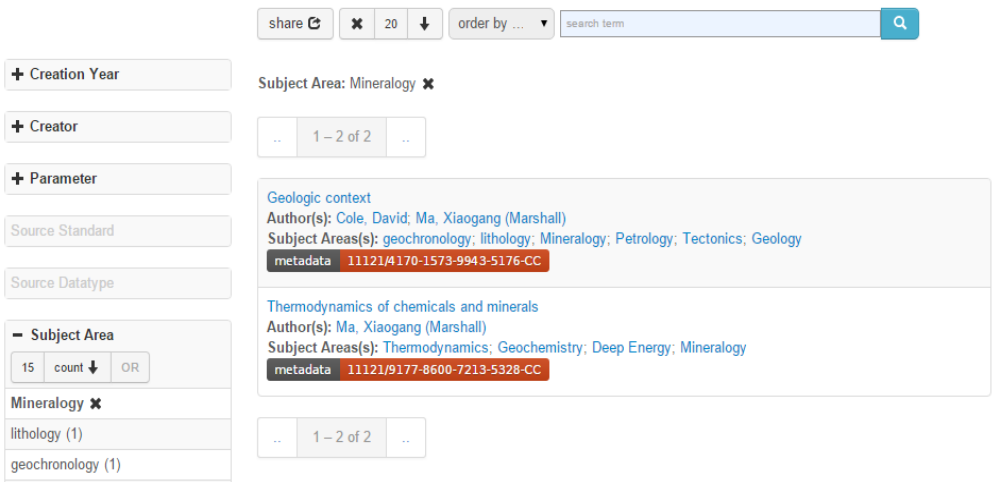
Figure 3. A faceted browser for registered data types.